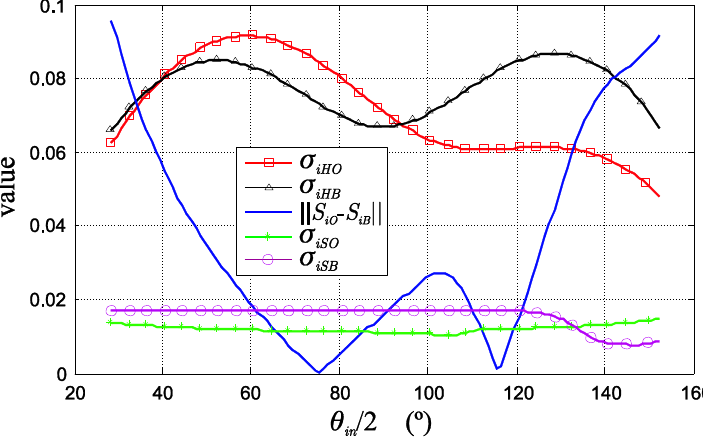
Figure 9. Hue and saturation deviation of both classes as a function of  between the saturation means of both classes is shown too.